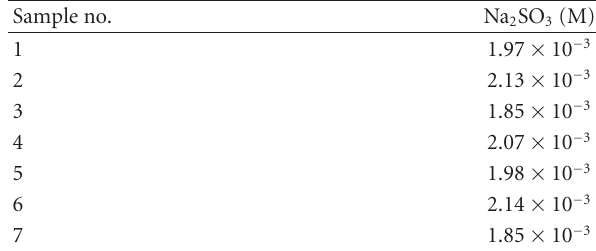
Table 2: Total SO 2 concentration obtained in gallic acid-sulfite so- lutions by the modified Monier-Williams method.